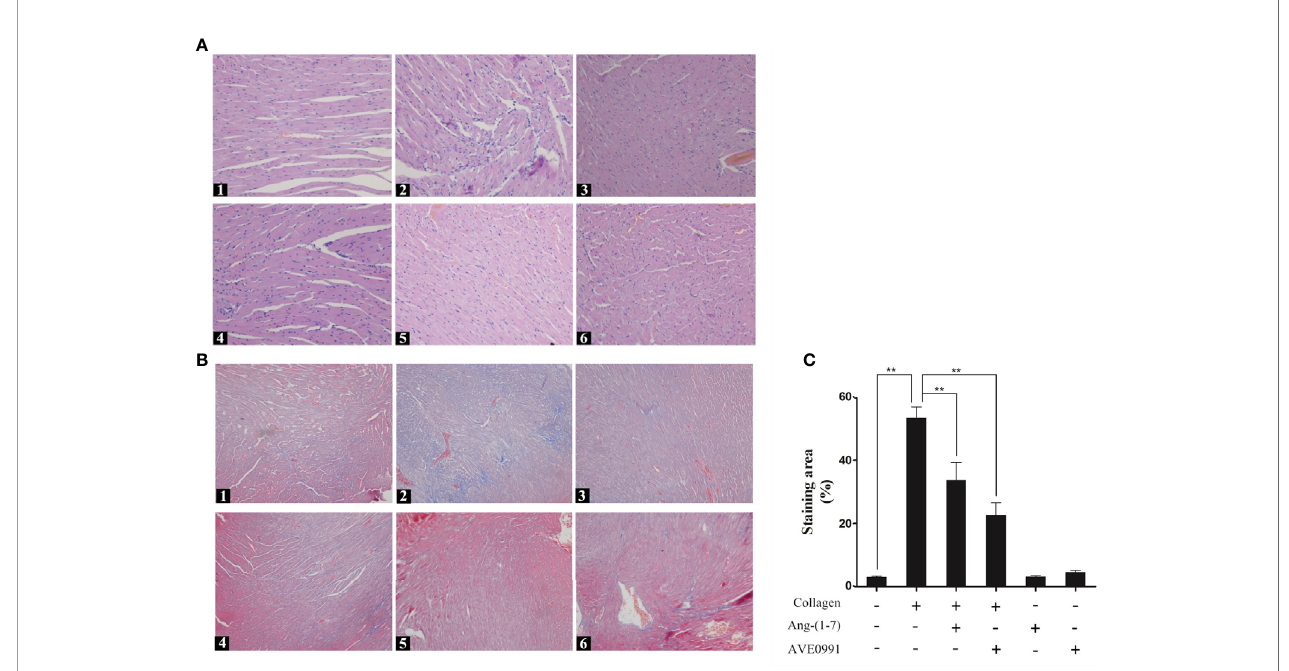
FIGURE 6 | H&E staining of heart in mice. (A1) Control group, (A2) CIA group, (A3) CIA + Ang-(1 – 7) group, (A4) CIA + AVE0991 group, (A5) Ang-(1 – 7) group, (A6) AVE0991 group. Magni fi cation = 200×. Masson staining of heart in mice. Representative Masson staining of heart in DBA/1 mice in all groups. (B1) Control group, (B2) CIA group, (B3) CIA + Ang-(1 – 7) group, (B4) CIA + AVE0991 group, (B5) Ang-(1 – 7) group, (B6) AVE0991 group. (C) Quanti fi cation fi brous staining region evaluated with Image-Pro Plus v 6.0. Values are expressed as means ± SD (n = 6). **P <